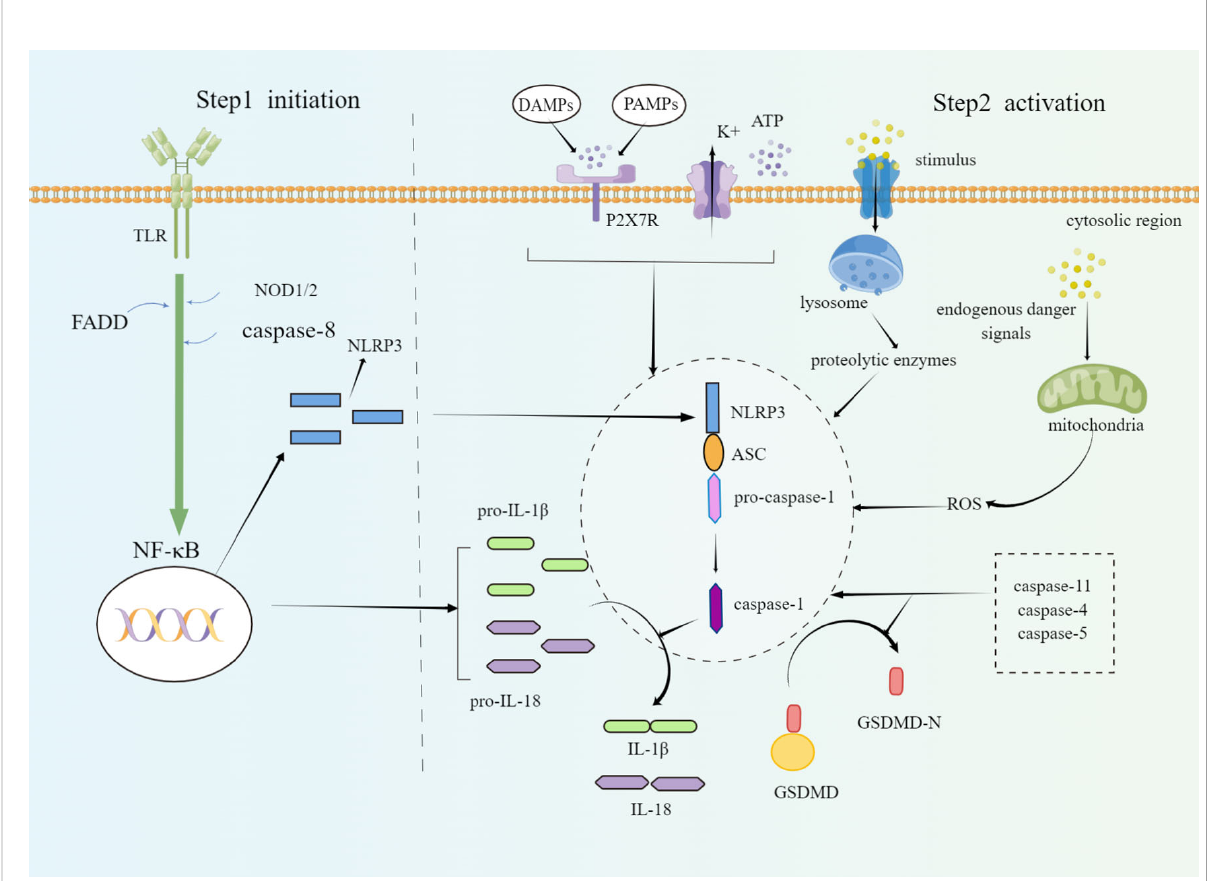
FIGURE 1 Schematic diagram of the molecular mechanism of NLRP3 in fl ammasome priming and activation. The priming steps of NLRP3 are regulated by TLR, FADD, caspase-8, and NOD1/2, which facilitate the activation of NF- k B and induce the activation of NLRP3. Canonical conditions of NLRP3 in fl ammasome oligomerization and activation include ATP, P2X7R, lysosomal damage, cathepsin release, K + out fl ow, mitochondrial ROS damage, etc. On the one hand, activated caspase-1 cleaves GSDMD into a lipophilic N-terminal soluble in the cytoplasm and a hydrophilic C- terminal that can be embedded into the cell membrane. The GSDMD-N terminal domain will combine with the phospholipids on the cell membrane to form holes and induce pyroptosis. On the other hand, activated caspase-1 releases in fl ammatory cytokines such as IL-1 b and IL- 18. Non-canonical NLRP3 in fl ammasome activation is mediated by caspase-4, caspase-5, and caspase-11. By